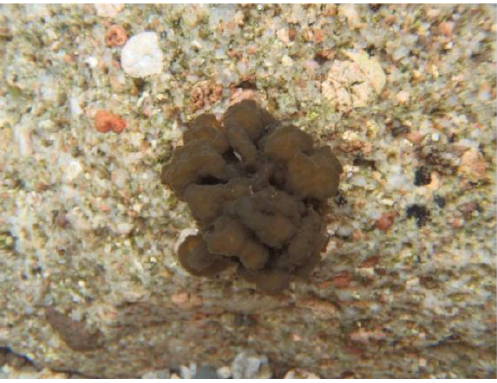
Figure 1. Nostoc verrucosum ( ashitsuki ) colony in a shallow stream.